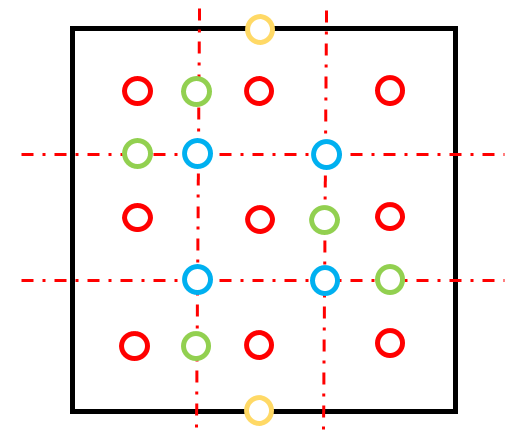
Figure 5. Arrangement of thermocouple.